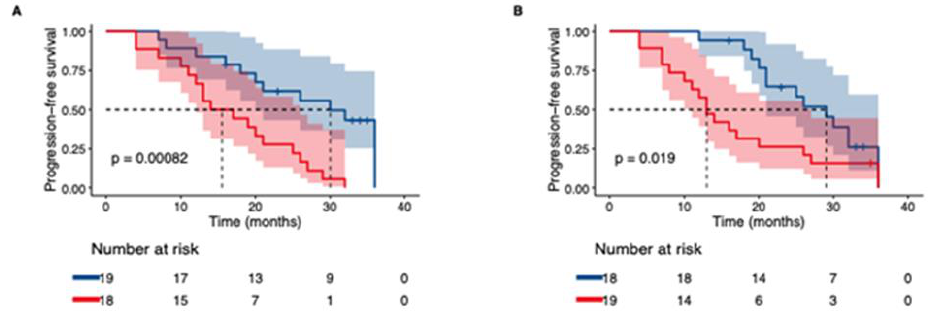
Figure 5. Kaplan–Meier curves for time to first IPF-progression (defined as ≥ 10% relative decline in FVC% or ≥ 15% decline in DLCO%). Lung function tests over a 36 months period from baseline were considered. Groups are stratified by protein change (elevation/reduction) observed at follow up. For each biomarker, red indicates the group of patients with elevated levels of respective protein observed at follow up. Blue indicates the group of patients with decreasing levels of protein observed at follow up. ( A ) MMP7, ( B ) TNFRSF12A.